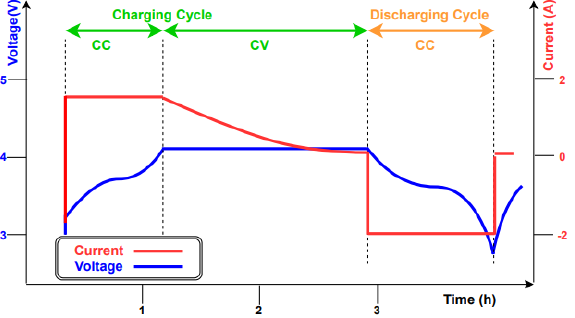
Figure 2. The CC-CV Process used in the NASA dataset.